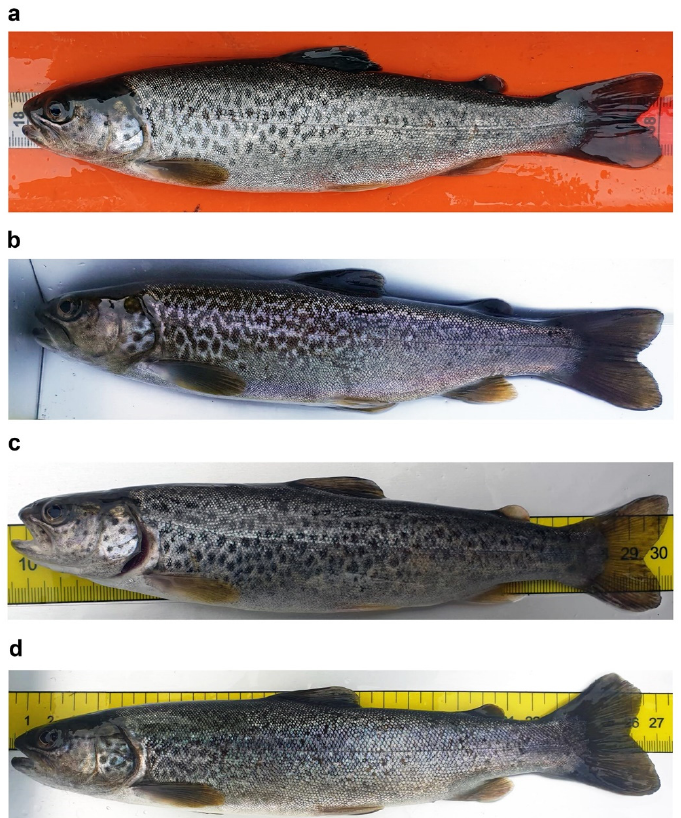
Figure 3. Examples of dotted coloration patterns in S. marmoratus : conspicuous ontogenetic chro- matic variation in pit-tagged individuals which were recaptured at different times; ( a , b ) subadult specimen sampled in Roledo (Piedmont, Verbano-Cusio-Ossola: VCO; 46°10 ′ 16.7 ″ N 8°18 ′ 49.7 ″ E), age and genetic data unavailable; ( a ) sampled on 28 April 2021, 20.0 cm TL, 86 g, dotted pattern; ( b ) recaptured in the same site on 28 October 2021, 23.4 cm TL, 122 g, marbled pattern; ( c , d ) Subadult specimen sampled in Prata di Vogogna (Piedmont, VCO; 46°1 ′ 40.8 ″ N 8°17 ′ 2.2 ″ E), age and genetic data unavailable; ( c ) sampled on 26 April 2021, 20.6 cm TL, weight not available, dotted pattern; ( d ) recaptured in the same site on 19 October 2021, 26.4 cm TL, 166.0 g, marbled pattern.